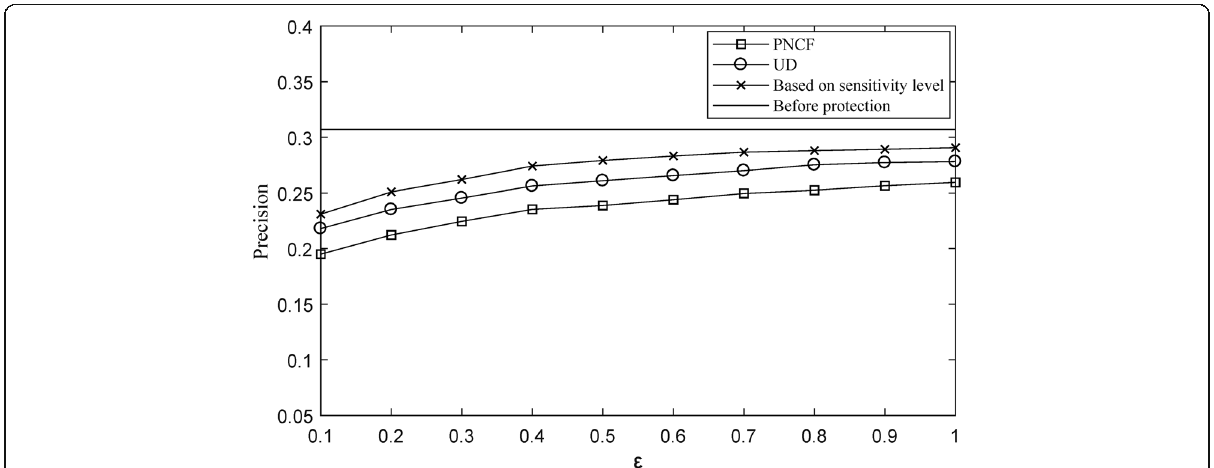
Fig. 6 Impact of differential privacy protection on